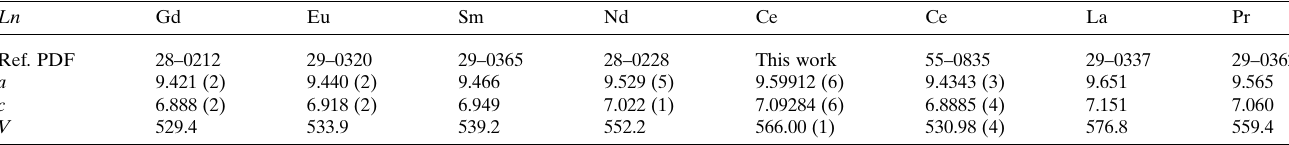
Table 2 Cell parameters (A˚ ) and volumes (A˚ 3 ) for the title phase compared with isotypic Ca 2 Ln III 8 (SiO 4 ) 6 O 2 phases. Ln Gd Eu Sm Nd Ce Ce La Pr Ref. PDF